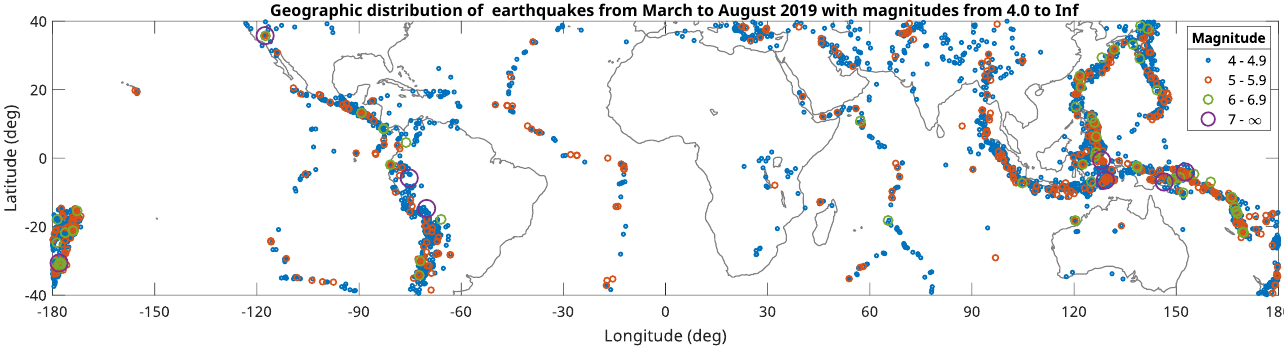
Figure 4. Geographic distribution of earthquakes occurring in the period from 1 March to 29 August 2019 with magnitudes larger to or equal than 4 within the region covered by CYGNSS. Magnitude is represented by the size and color of the